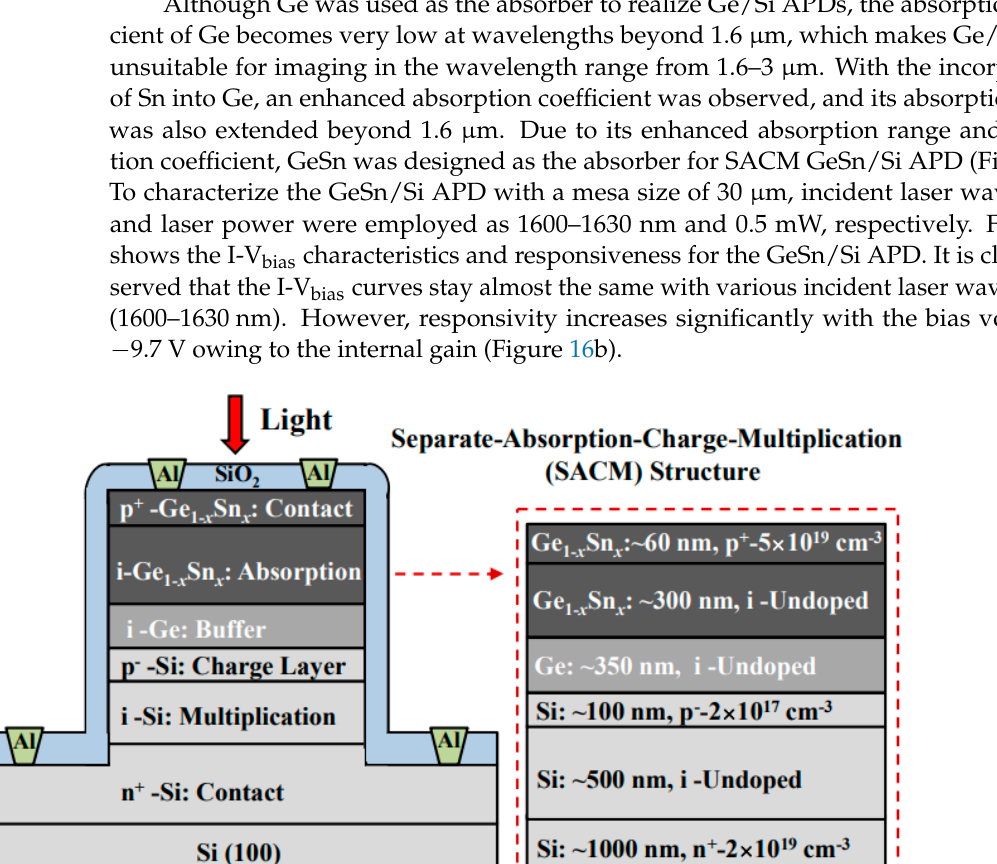
Figure 14. TEM images of ( a ) mesa-type Ge/Si APD by SEG growth; ( b ) total layer thickness. Reproduced from [69], OSA Publishing, open access, 2012.